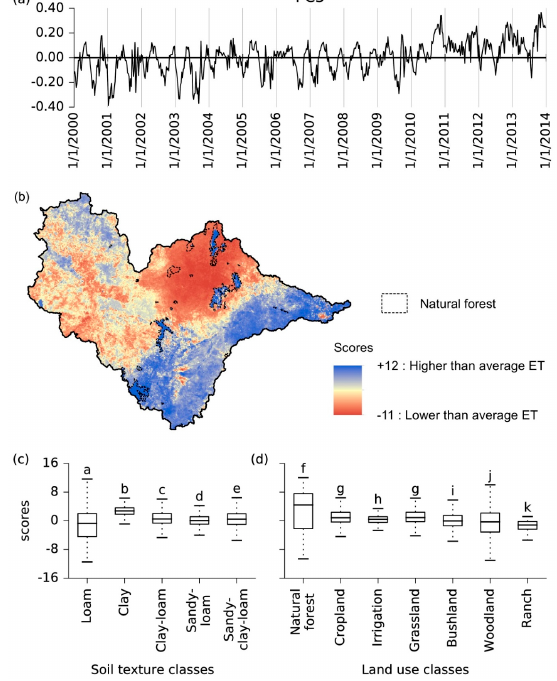
Figure 8. Time series of the loadings on the fifth principal component (PC5) ( a ). Map of the scores of PC5 and natural forest areas ( b ). Quartiles of the scores of PC5 for different soil texture ( c ) and land use ( d ) classes, similar score distributions at the 5% level of significance are marked with the same small letter.